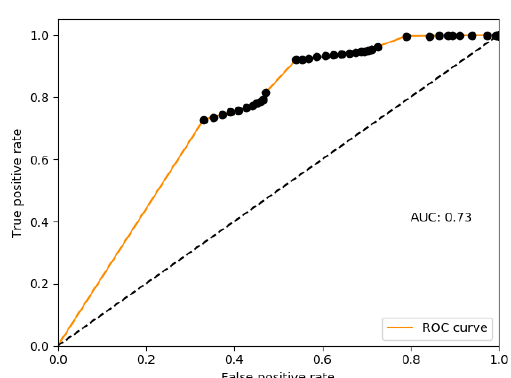
Figure A1. The receiver operating characteristic (ROC) and area under curve (AUC) using the HEC-RAS as reference map against the water depth map derived from surface water